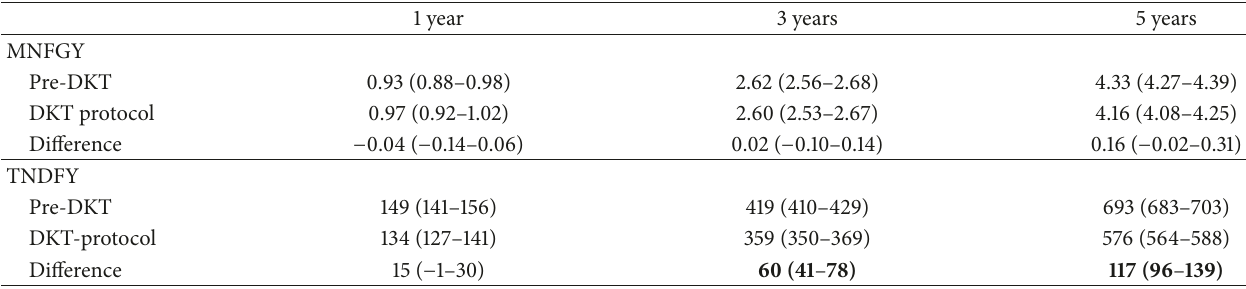
Table 5: Mean restricted number (95% confidence intervals) of functioning graft years by transplant reference (MNFGY) at 1, 3, and 5 years after transplantation, and calculated total number of dialysis-free life years for every 100 donors (TNDFY) at the same times in recipients, in the pre-DKT and DKT protocols. Differences shown in bold indicate a significant statistical difference ( P <